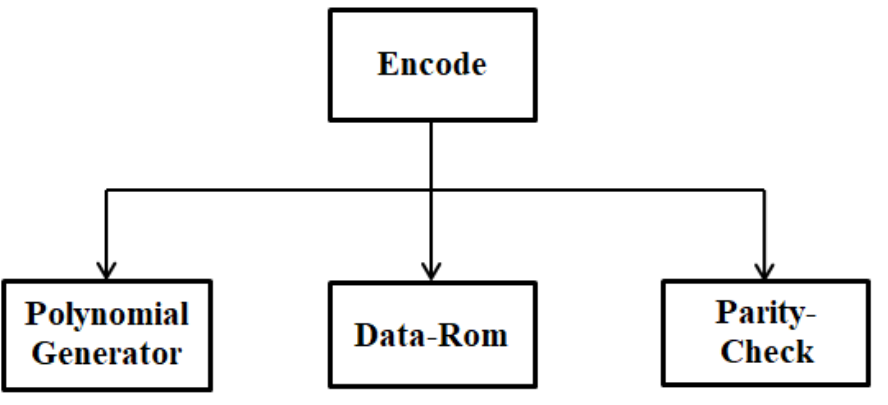
Figure 5. Encoding steps for Reed–Solomon.